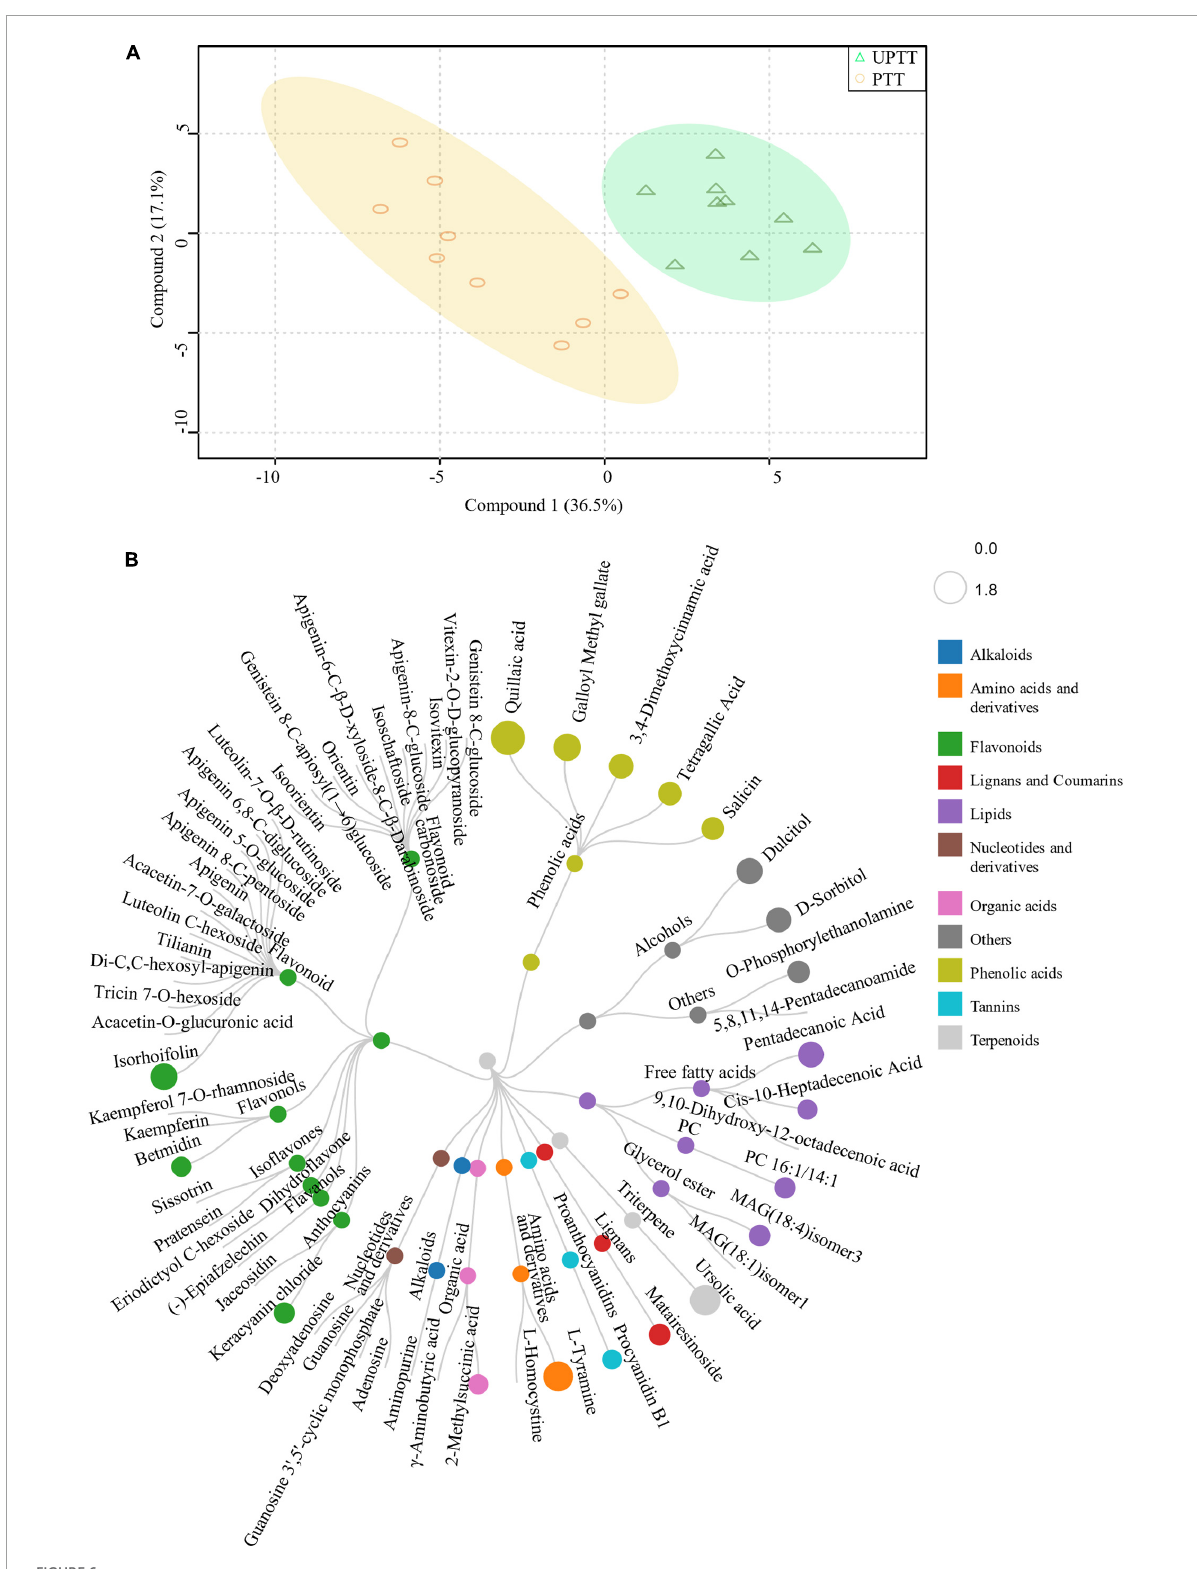
Frontiers in Nutrition